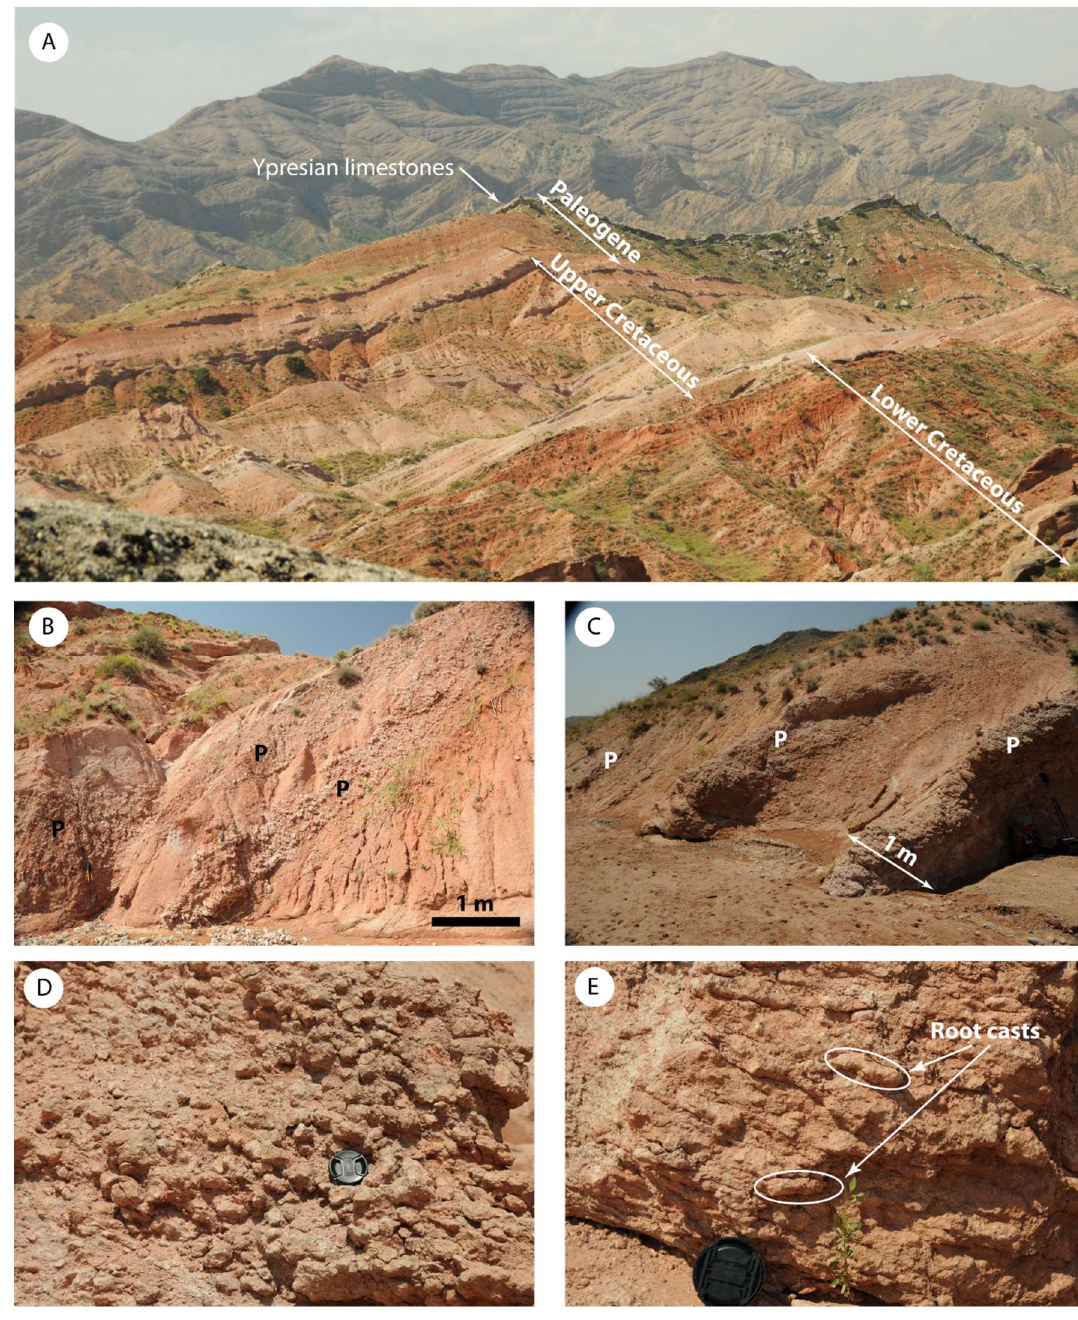
Figure 3. ( A ) General view of the Tash Komyr section (the distance is about 1.3 km from the base of the exposed Cretaceous series to the Ypresian limestones). ( B ) Early Cretaceous caliche layers (P). ( C ) Paleogene caliche layers (P). ( D , E ) Close view of the amalgamated root casts in the Early Cretaceous and Paleogene caliches.